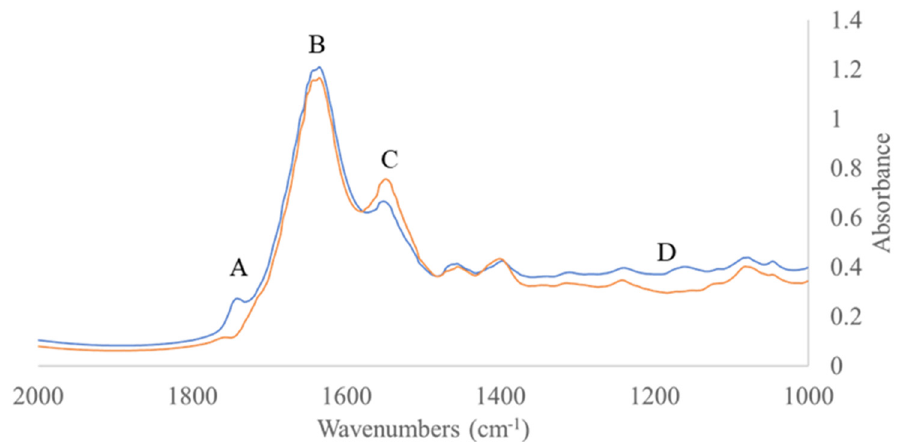
Figure 6. Predicted versus observed TVCs ( A ) and Pseudomonas spp. counts ( B ) by the PLS-R models, based on FT-IR data for FCV (open symbols) and prediction (solid symbols). Solid line represents the line of equity (y = x) and dashed lines indicate ± 1.0 log unit area.